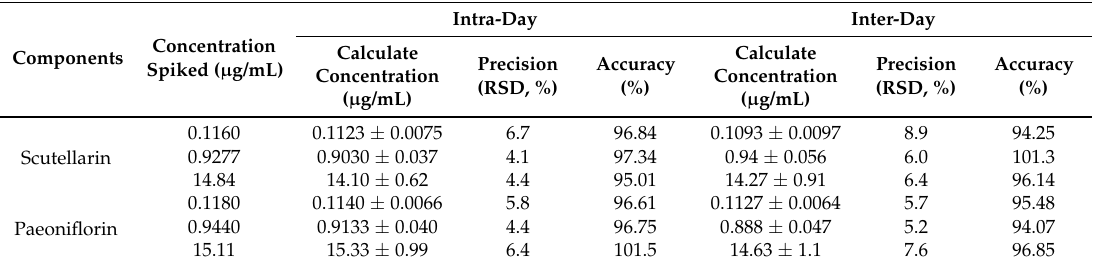
Table 1. Precision and accuracy of UPLC-MS/MS method for assay the two analytes in rat plasma (mean ± SD, n = 5).